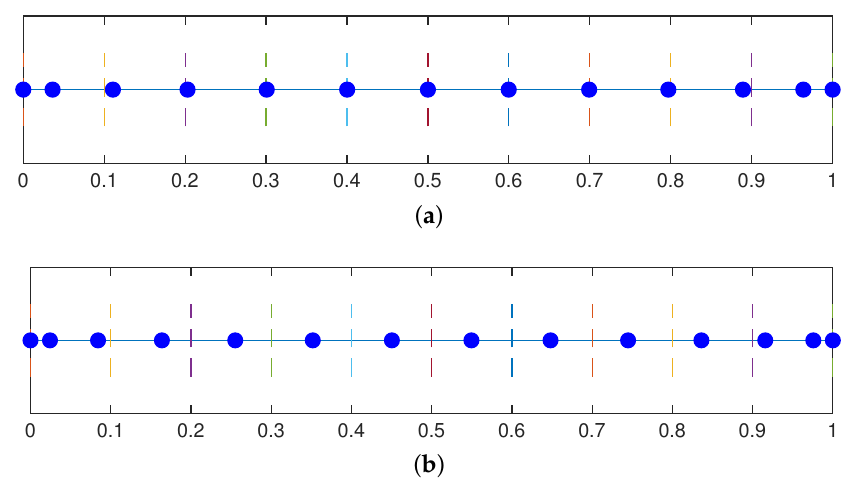
Figure 3. Demko points. ( a ) Odd degree ( p = 3). ( b ) Even degree ( p = 4).